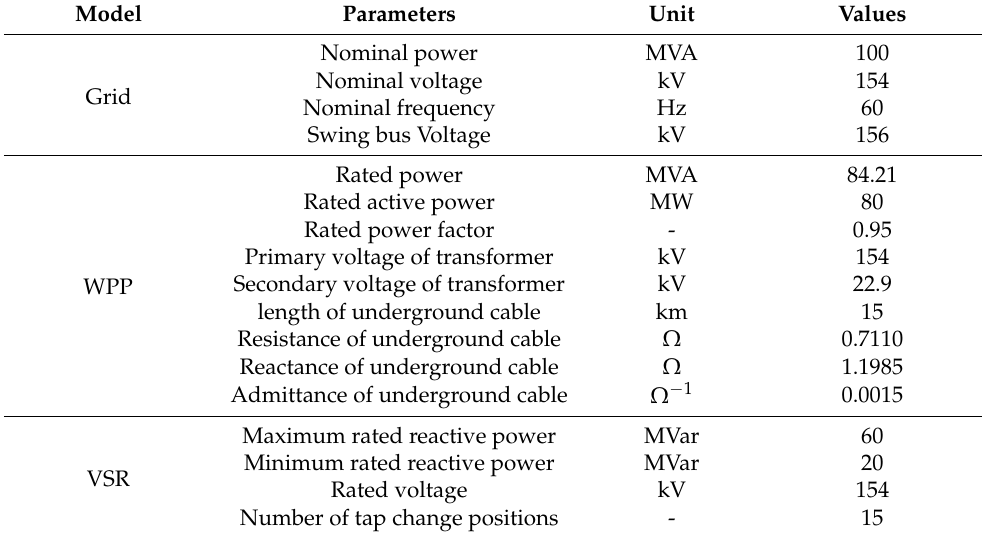
Figure 7. Set–point change of reactive power control using a VSR. Table 2. Simulation model